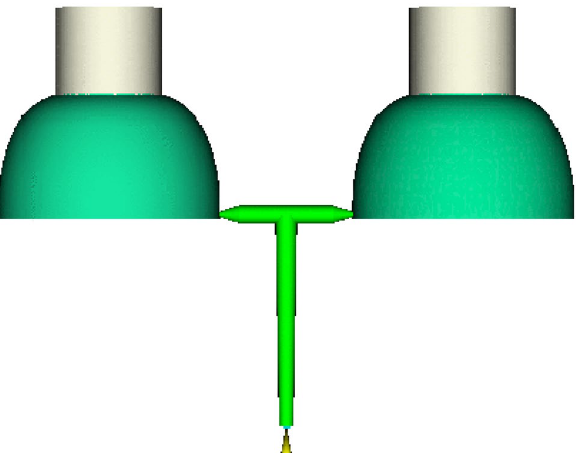
Figure 2. One mold two cavity hydrogen storage cylinder liner injection structure and gate